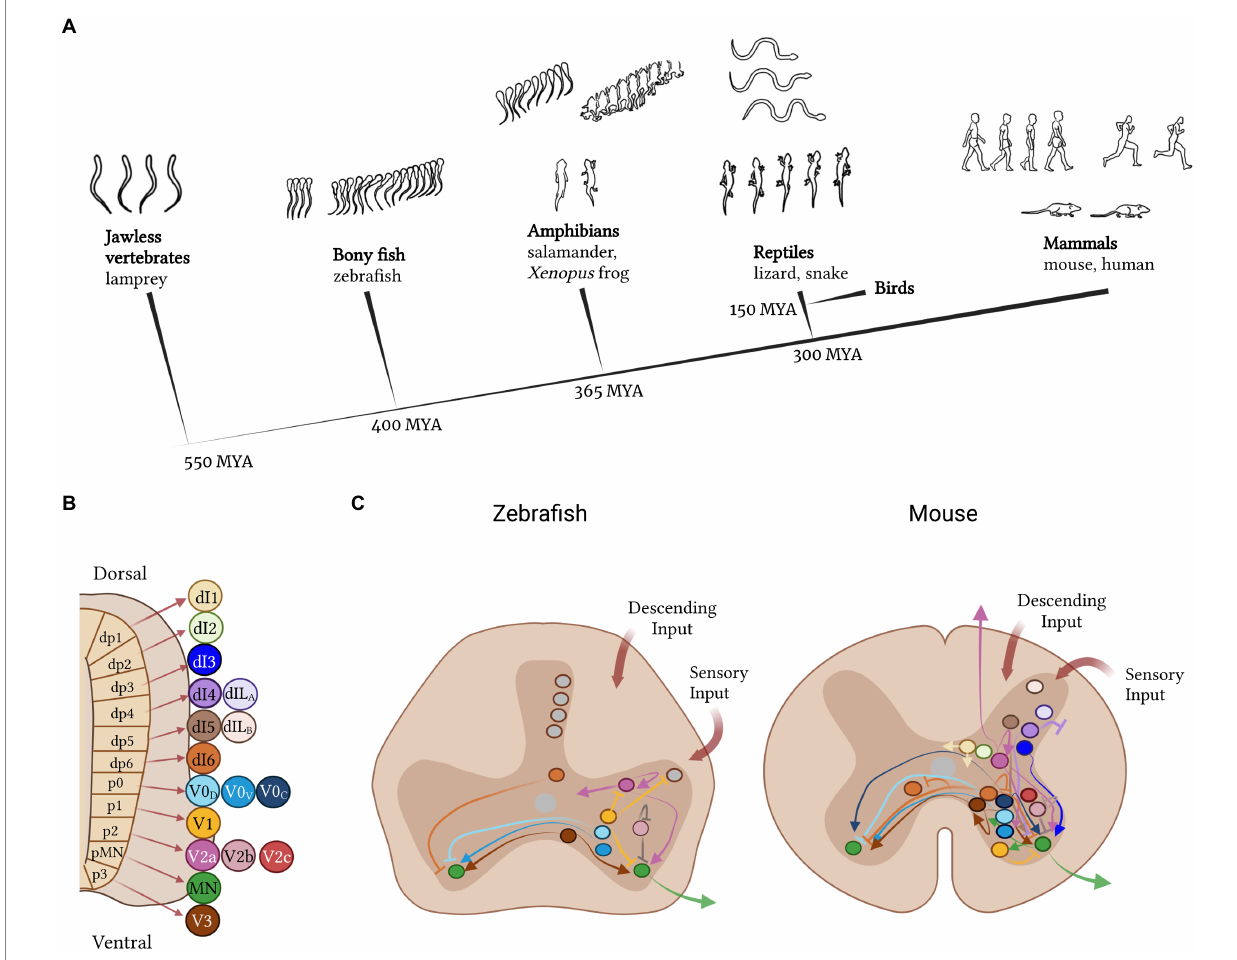
FIGURE 1 A cross-species comparison of the neural basis of vertebrate movement. (A) Cladogram of vertebrate evolution with illustrations of movement patterns for each of the species listed as examples. The lamprey is the most primitive vertebrate and exhibits simple, undulatory swimming; zebrafish display more complex swimming patterns; the frog and salamander use both tail and limbs for movement; reptiles exhibit diagonal limb coordination; and mammals display complex fore − /hindlimb gaits. (B) Cardinal neuron classes that make up the spinal cord circuitry are derived from 11 progenitor domains. Some domains give rise to more than one neuron class, e.g., the p2 domain gives rise to the V2a, V2b, and V2c interneurons. (C) Comparison of interneuron subtypes and projection patterns in the spinal cord of zebrafish versus mice. Colors represent different neuron classes; gray represents neurons without a clear cardinal class